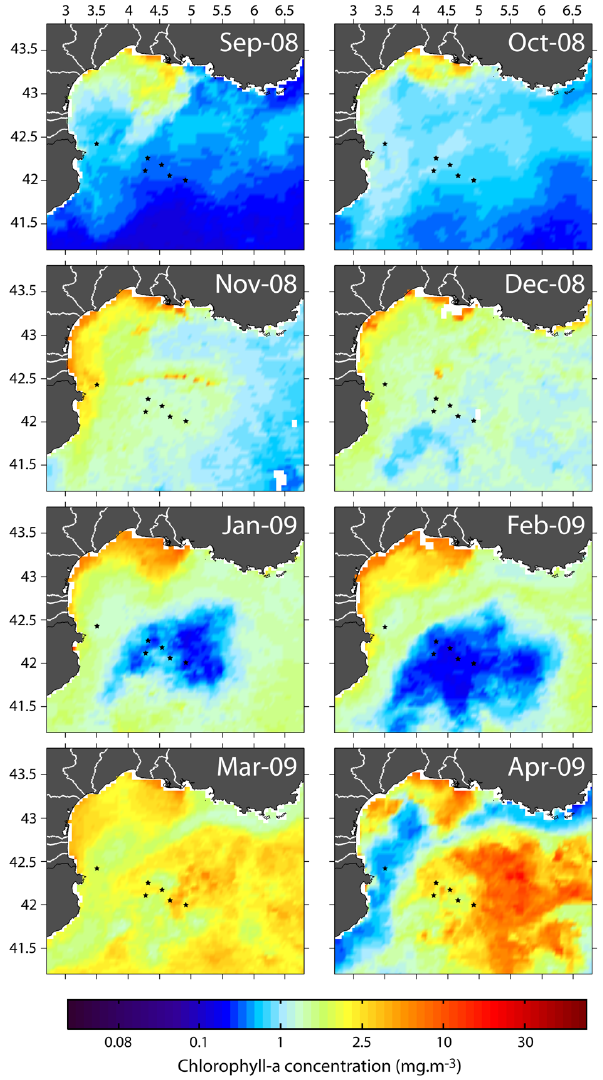
Fig. 3. Monthly averaged MODIS-Aqua 4km surface chl a images from September 2008 to April 2009. The black stars indicated the location of the mooring sites. Satellite data were downloaded from NASA’s Giovanni portal